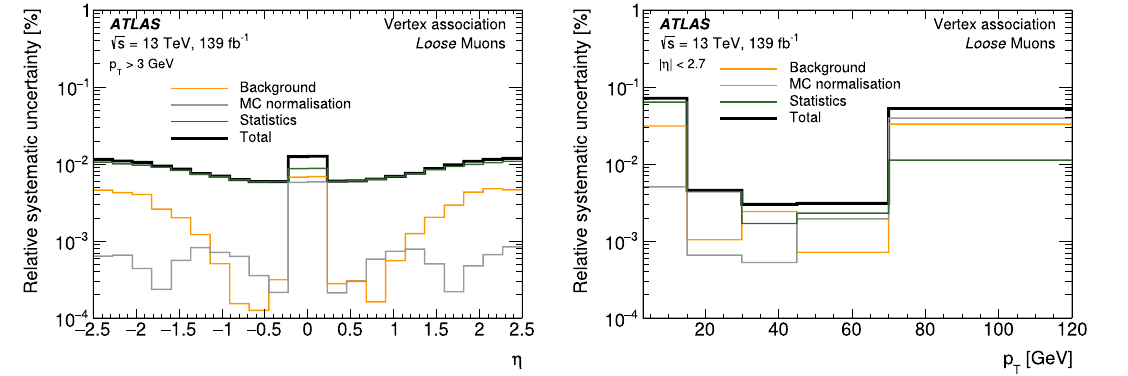
shape , (cid:15) - SC , and Background fit uncertainties, whereas the MC nor- malisation comprises the Cross-section and Luminosity uncertainties. The total uncertainty is the sum in quadrature of the individual contri-